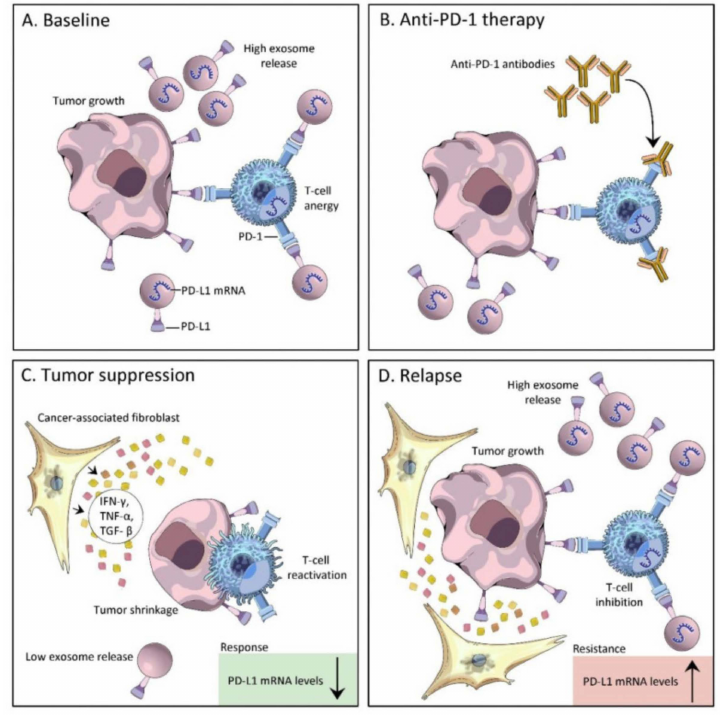
Figure 6. Exosomal PD-L1 correlates with tumor response and resistance to anti-PD1 therapy: ( A )